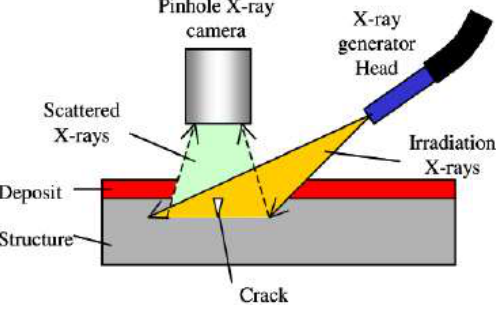
Figure 14. X-ray backsca(cid:308)er testing system, adapted from [31].